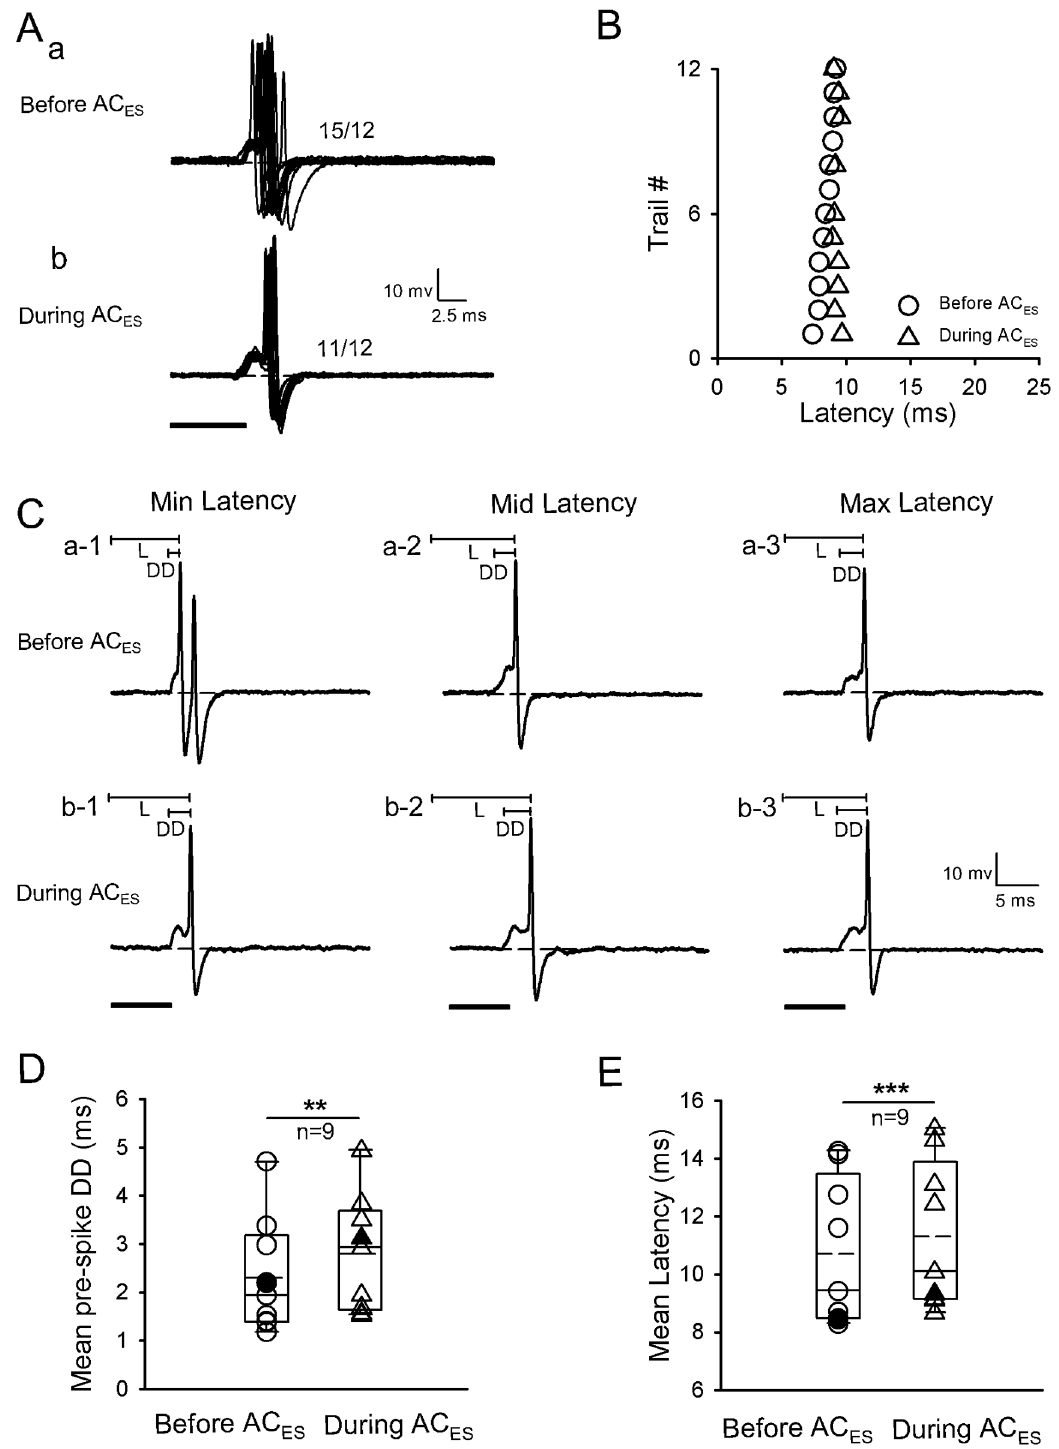
Fig 5. Representative inhibited IC neuron by AC ES showing its latency increasing induced by pre-spike DD lengthening. (A) Originalresponsetraces obtained by 12 repetitive pure tone stimulationconditions before (Aa) and during(Ab) AC ES . (B) Distributionof latency values calculatedaccordingto Aa and Ab before (unfilledcircle) and during (unfilledtriangle)AC ES . (C) Three representative (i.e., minimum(a-1, b-1), middle(a-2, b-2), and maximum (c-1, c-2)) latenciesselectedfrom Aa and Ab before (Ca-1–a-3) and during(Cb-1–b-3)AC ES . (D) Comparisonof mean